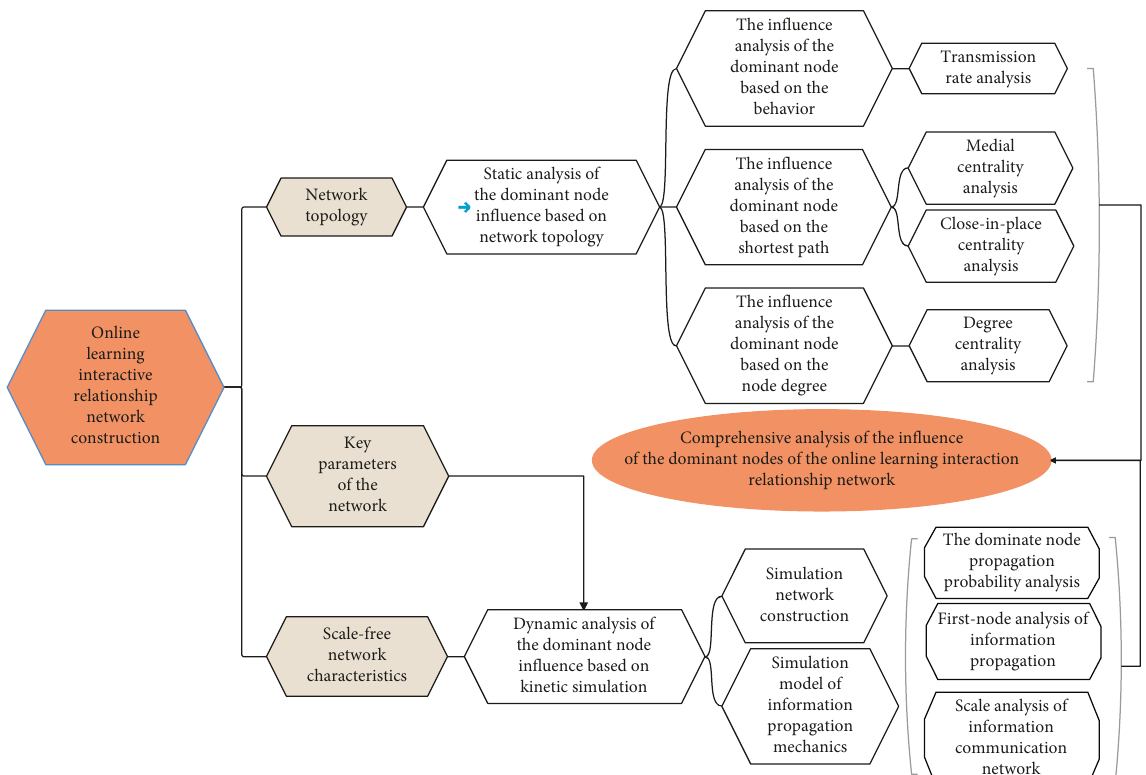
Figure 7: Comprehensive analysis of the influence of dominant nodes in the online learning interaction network.